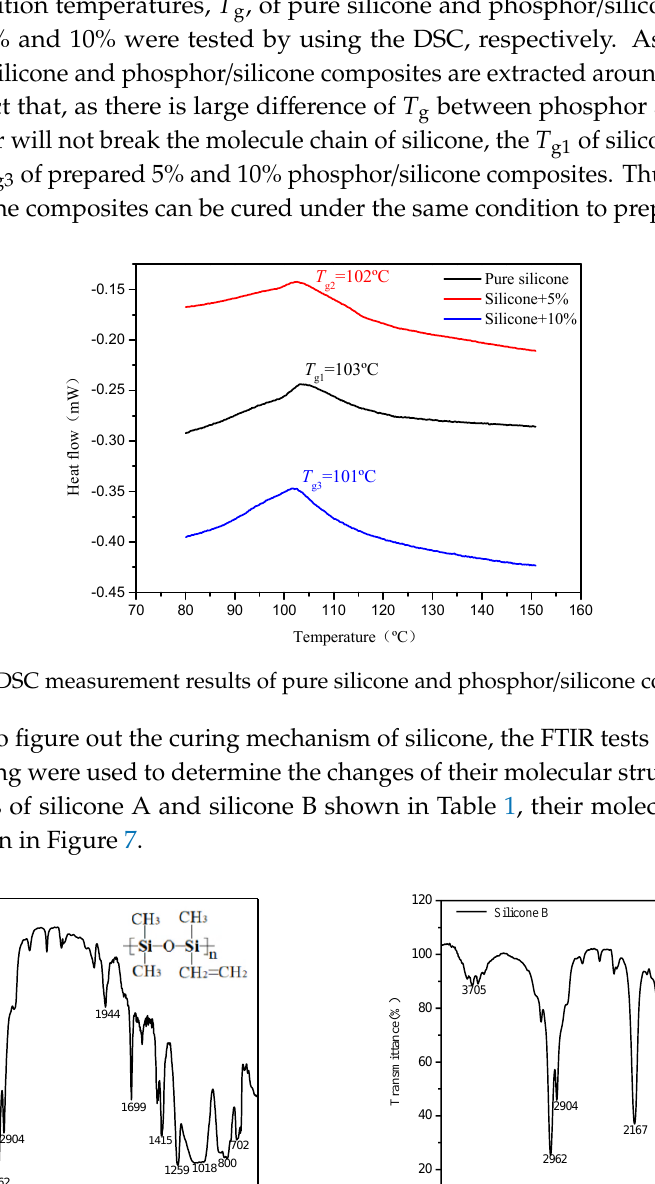
Figure 5. In situ viscosity measurement data of ( a ) pure silicone and ( b ) phosphor/silicone composites and their fitting results by the Arrhenius model.